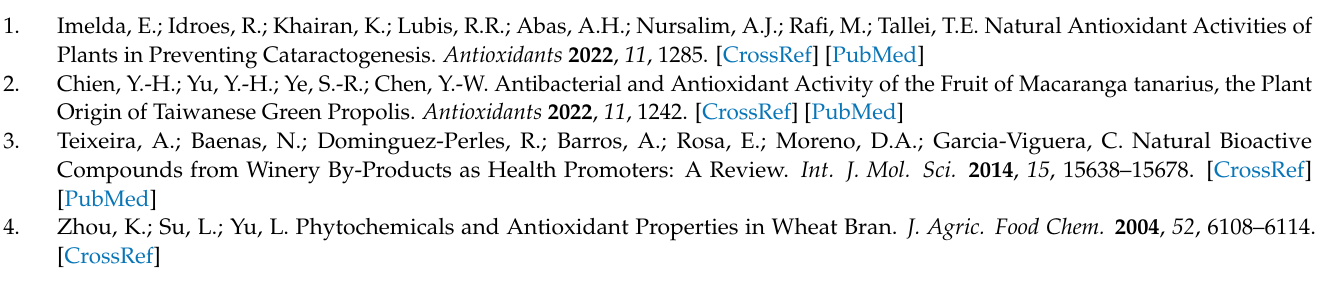
study on fibroblast cells; Table S4: Statistical analysis of permeation studies; Table S5: Statistical ysis of TEWL index; Table S8: Statistical analysis of moisture level; Table S9: Statistical analysis of sebum level; Table S10: Statistical analysis of elasticity of skin; Table S11: Statistical analysis of wrinkles; Table S12: Statistical analysis of pH of the skin; Table S13: Statistical analysis of pore sizes; Table S14: Comparison of measuring options for B-NLC-E and